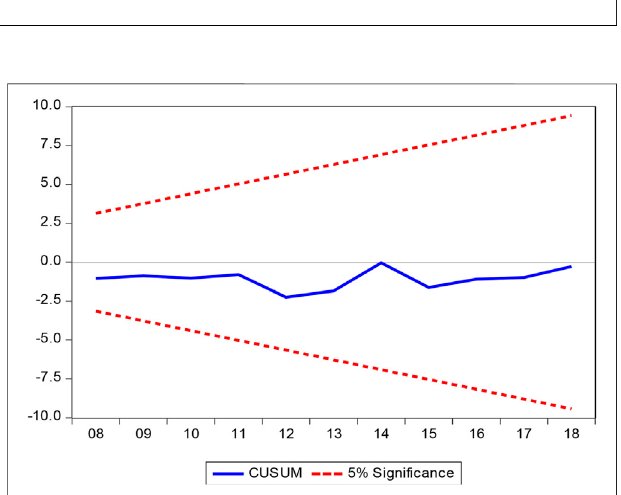
FIGURE 3 | Graphical presentation of empirical fi ndings.